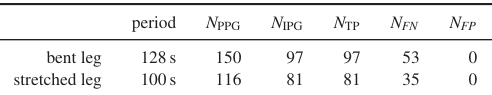
Tab.1: Measurement period and number of detected pulse waves for the bent and stretched leg.